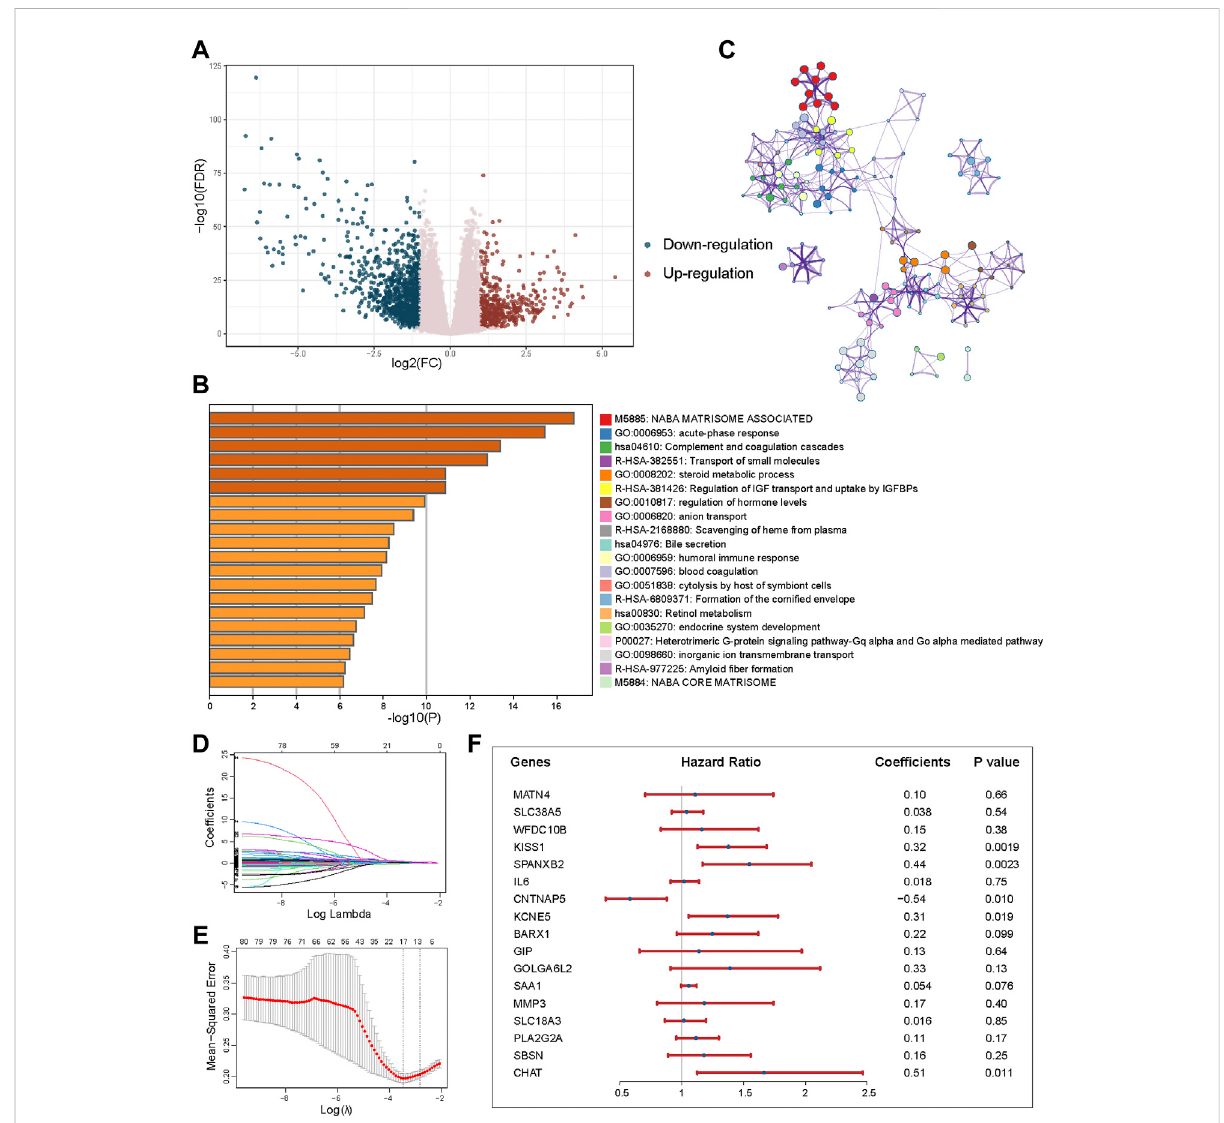
FIGURE 4 Identi fi cationofDEGsbetweensubtypesandconstructionoftheprognosticmodel. (A) Volcanoplotshowingthedifferentiallyupregulated(red points) and downregulated genes (blue points). (B) Pathway and process enrichment analysis has been carried out for 344 DEGs that identi fi ed betweensubtypes.Thegraphicalrepresentationshowedtop20enrichmentswith p < 0.01. (C) Enrichmenttermswithasimilarity > 0.3areconnected by edges. (D) LASSO coef fi cient pro fi les of 80 prognostic DEGs. (E) Cross-validation for tuning parameter selection in the LASSO model. (F) Forest plot of the multivariate regression of 17-genes in prognostic